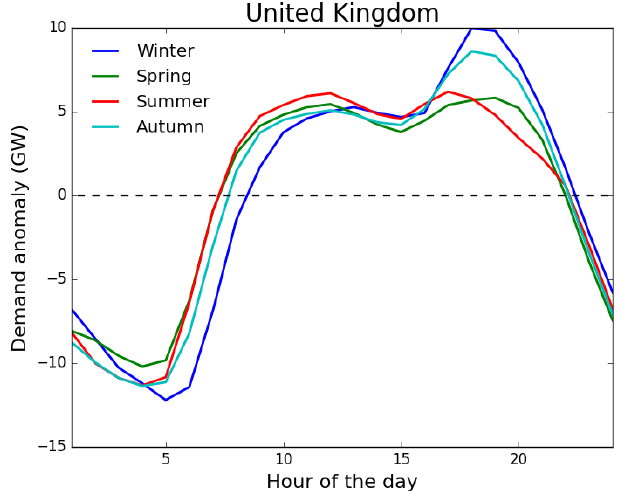
Figure A1. Composite diurnal demand cycles for each meteo- rological season of the year, expressed as an anomaly from the mean daily demand. Seasons are defined as spring (March–May), summer (June–August), autumn (September–November) and win- ter (December–February.) created from the average of the 2016– 2017 demand data from ENTSOE (2018).